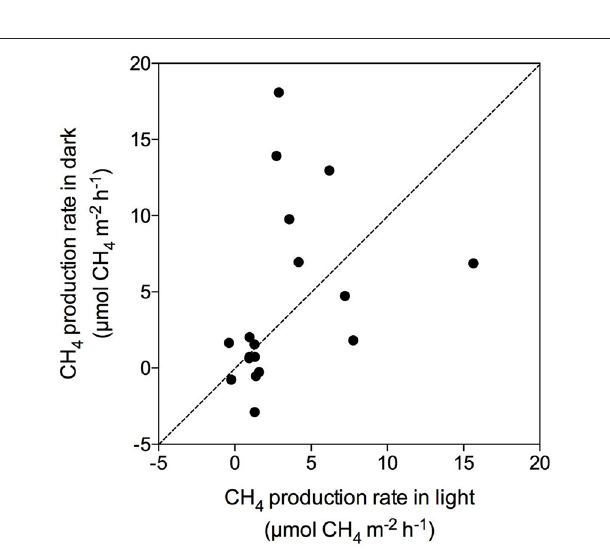
2015), suggesting CH 4 oxidation by photosynthetic oxygen.